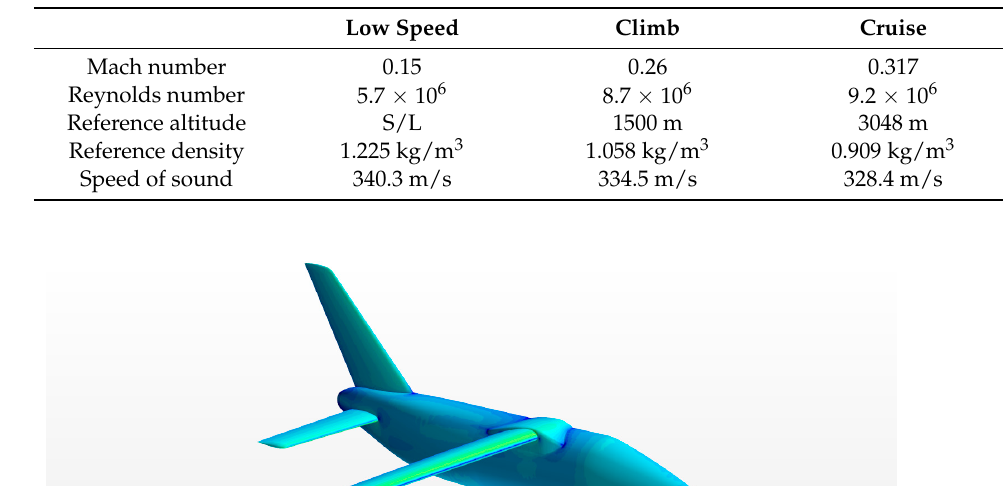
Figure 3. Convergence plot for lift coefficient ( a ) and drag coefficient ( b ). Cruise condition, M = 0.32, Re = 9.2 Mil.